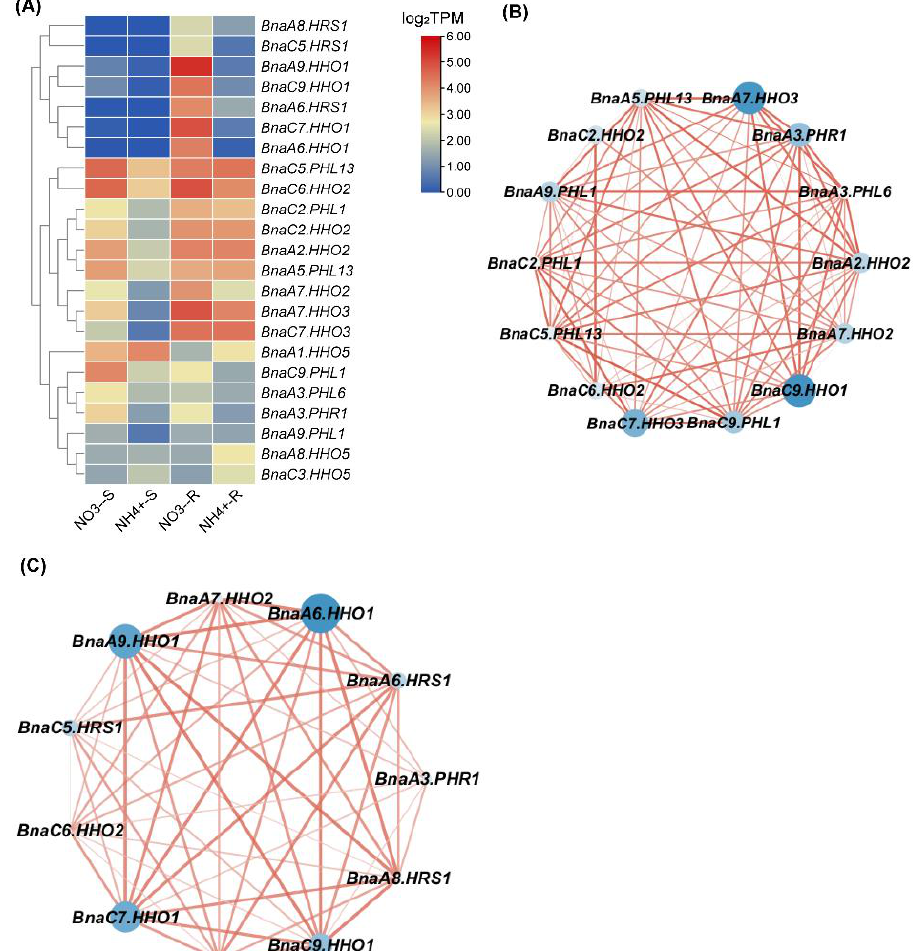
Figure 9. Expression profiles ( A ) and co-expression network analysis of BnaGARPs in the shoots/S ( B ) and roots/R ( C ) under different nitrogen (N) form conditions, including 6.0 mM nitrate (NO 3 − ) and 6.0 mM ammonium (NH 4+ ) conditions. The expression levels are normalized by log 2 (TPM). TPM, transcripts per million (reads). In the heat maps, the color scales represent relative expression levels from high (red color) to low (blue color). In the gene co-expression networks, the cycle nodes represent genes, and the size of the nodes represents the power of the interrelation among the nodes by log 2 FC value. FC, fold change. The edges between two nodes represent interactions between genes.